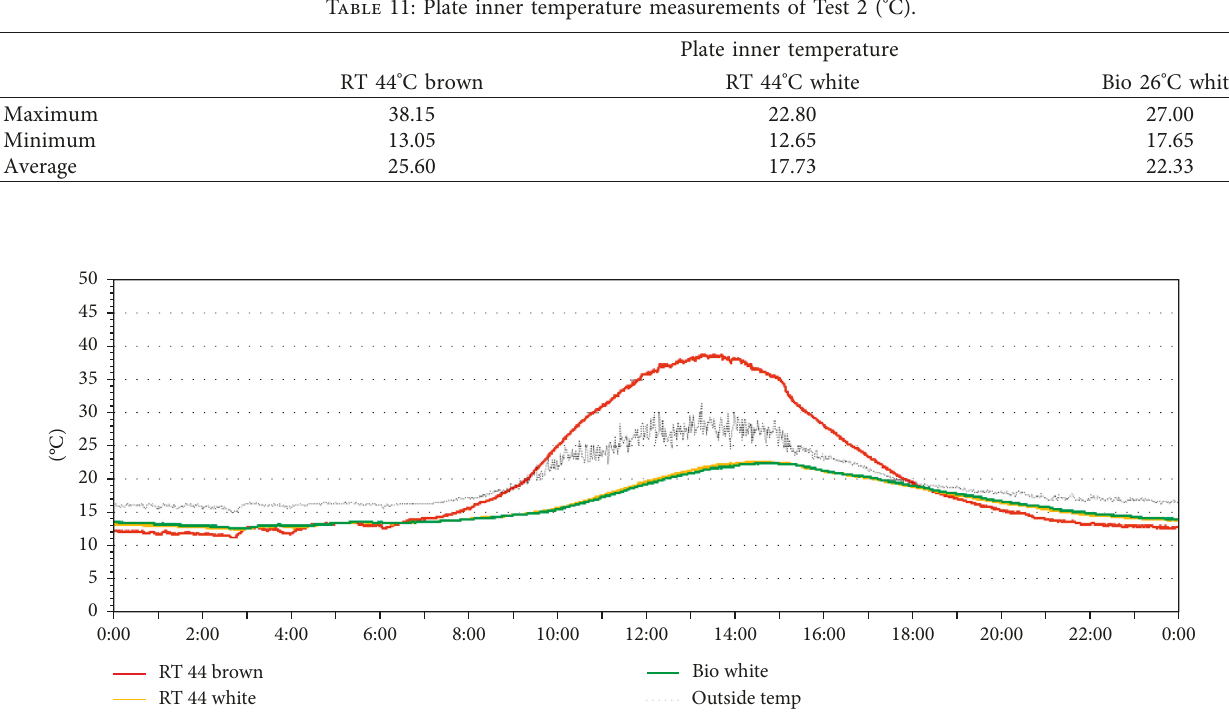
Figure 11: Plate inner temperature graph of Test 2.